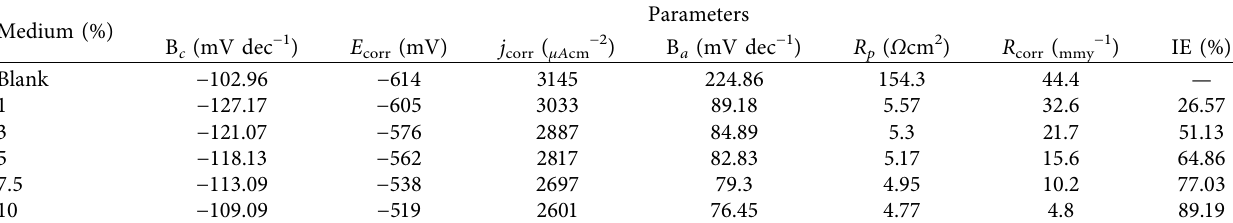
Table 4: Tafel constraints obtained from polarization curves from Tafel extrapolation technique of steel alloy 4130 trial immersed in 3.5 wt.% NaCl medium and diverse loads of LI. Medium